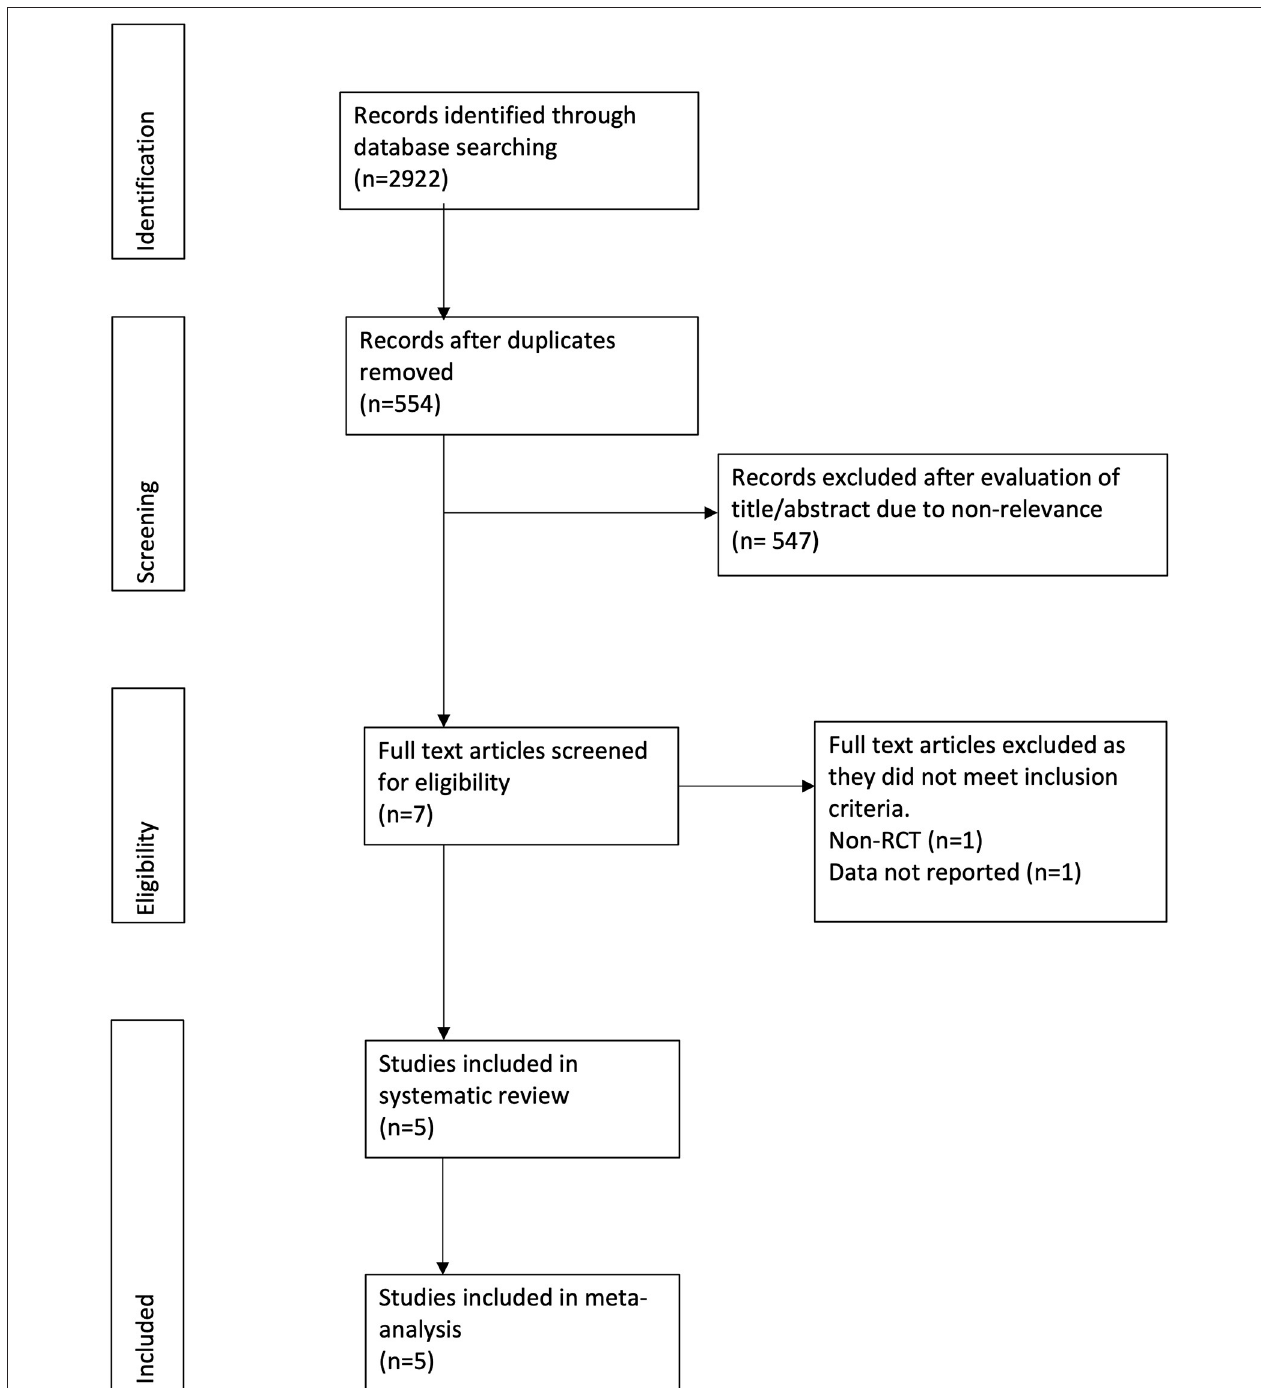
FIGURE 1 | Study flow